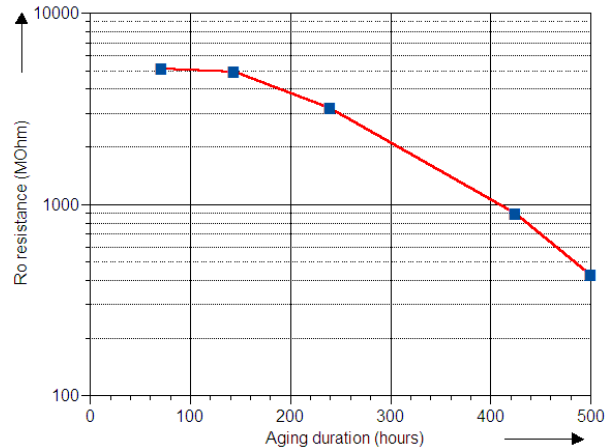
Figure 5. Predicted variation of the resistance R ageing duration.